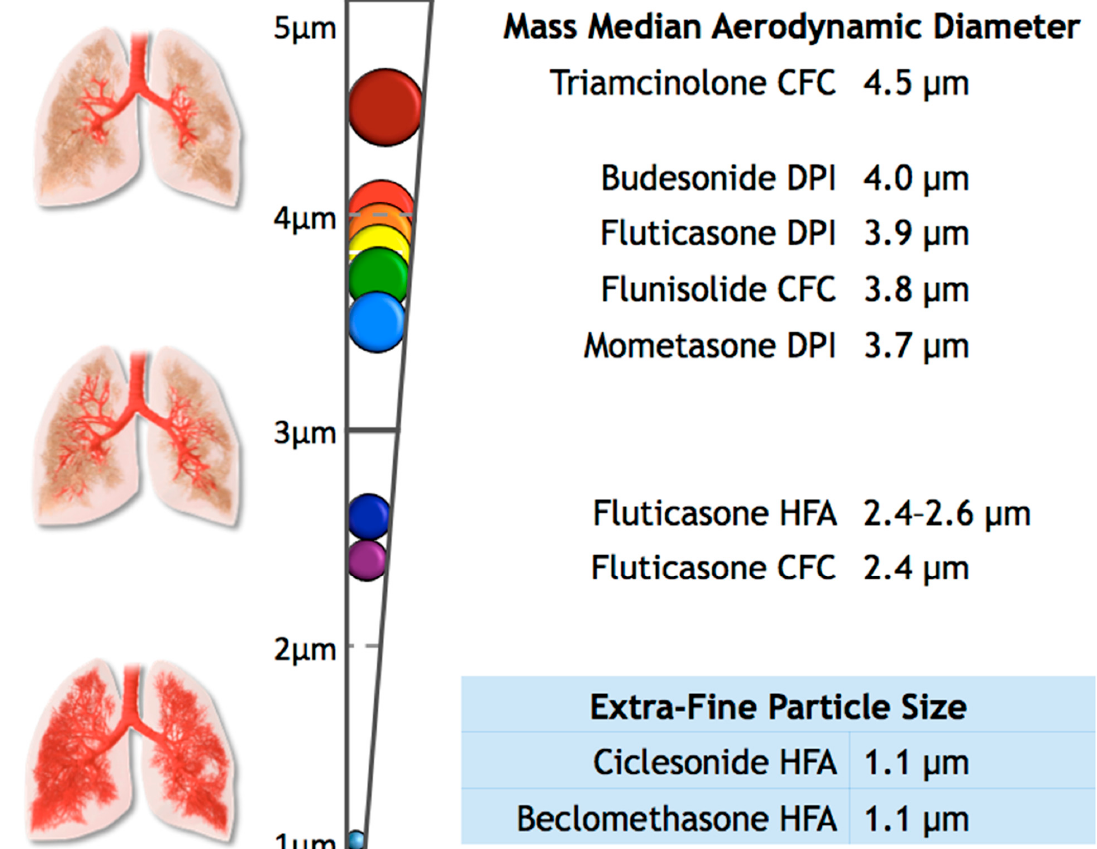
Table 1. Demographic data of the study